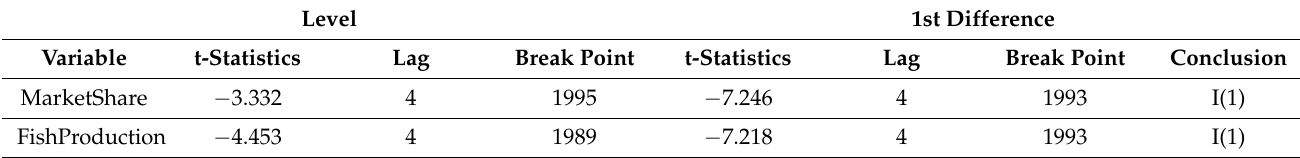
Table 3. Ziviot–Andrews